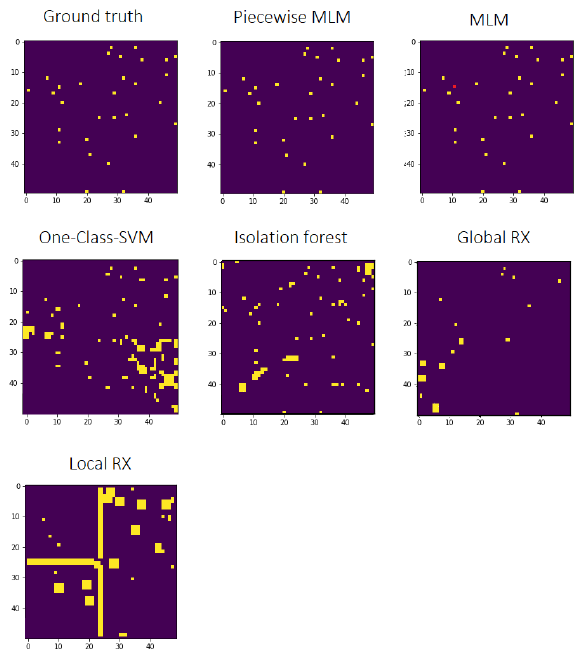
Figure 10: The anomaly detection maps of the ColorChecker dataset. The ground truth, the Piecewise MLM and the MLM: implemented with cosine distance metric, using variance and two thresholds (explained in subsection 3.1). The size of the X was 2500, and R was 250. The anomaly maps of the reference meth- ods are originally from the (P¨ol¨onen et al., 2020).